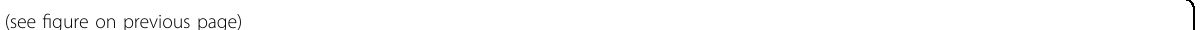
Fig. 5 RNA-seq analysis of the prefrontal cortex (PFC) of control-2 and M2 monkeys reveals upregulation of genes for myelination and glial function. a Summary of differentially expressed (DE) genes in M2 PFC compared to control-2 PFC. Signi fi cance cutoffs correspond to log2 (fold change) > 1.5 and adjusted P value ( P adj) < 0.05. b Reduced CHD8 expression in M2 brain cortex in RNA-seq analysis. ** P < 0.01. c Representative signi fi cant gene ontology (GO) terms for DE genes of up- and downregulation. Odds ratio > 2 and P adj < 0.05. d Expression levels of enriched transcription factors for neurons, astrocytes and oligodendrocytes demonstrate upregulation in gliogenesis, but not neurogenesis. The data were obtained by averaging three samples and presented as means ± SEM. e Heatmap analysis of neuron, astrocyte, and oligodendrocyte-speci fi c genes revealing upregulation in oligodendrocyte-enriched genes but not in neuron-enriched genes. Fold change was plotted on a log 2 color scale, with blue representing lower expression and red representing higher expression in M2 than control-2. f Western blotting showing the increased expression of full-length (fMYRF), N-terminal (nMYRF) MYRF and Sox9 in the brain cortex of M2 when compared with control-2. The ratios (means± SEM) of MYRF and Sox9 to the loading control actin were obtained by quantifying the intensity of MYRF, Sox9, and actin on three independent western